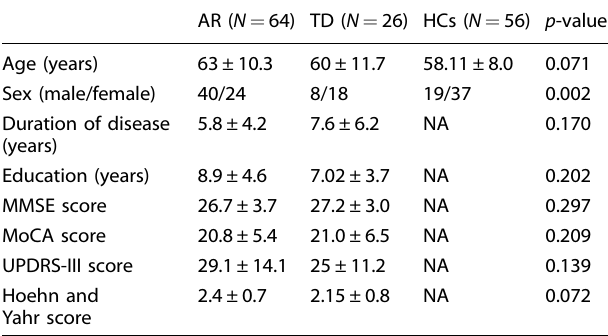
Table 2. Demographic and clinical data of the PD patients and